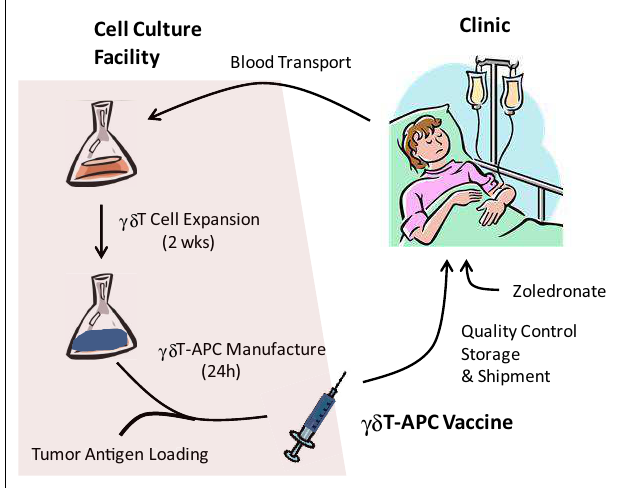
FIGURE 1 | Manufacture of tumor antigen-loaded γδ T-APC for immunotherapy .Venous blood samples from cancer patients are shipped to the centralized γδ T-APC manufacture facility. Isolated PBMC are stimulated with single doses of zoledronate and expanded during in vitro culture for 2weeks in the presence of IL-2 and IL-15. Expanded γδ T cells are treated for 24h with tumor antigen (purified proteins, cell extracts) or, in cases of low purity, enriched by magnetic beads isolation prior to tumor antigen treatment. After reformulation, the γδ T-APC vaccine undergoes quality control tests and is frozen for transport to the clinic. γδ T-APC vaccine infusions may be followed by i.v. injections of zoledronate in order to trigger γδ T-cell responses (cytokine secretion, lymph node